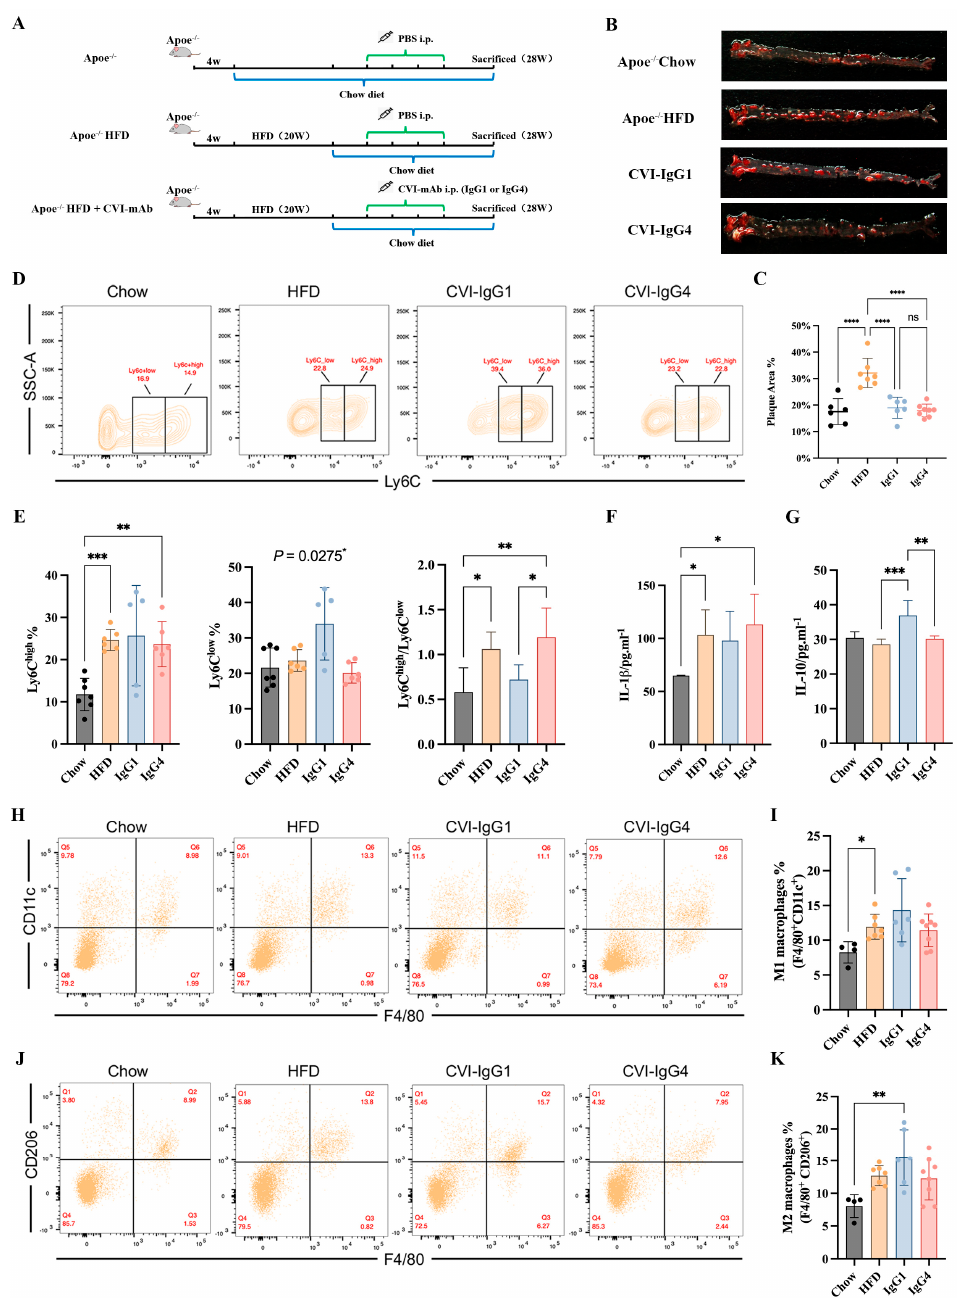
Figure 5. Anti-CVI-mAb adoptive transfer induced HFD-induced atherosclerotic plaque regression in Apoe -/- mice. ( A ) Experimental scheme for high-fat diet-fed mouse and antibody therapy strategy. ( B ) Aortic Oil red O staining of different groups. ( C ) Percentage of plaque area of the entire artery